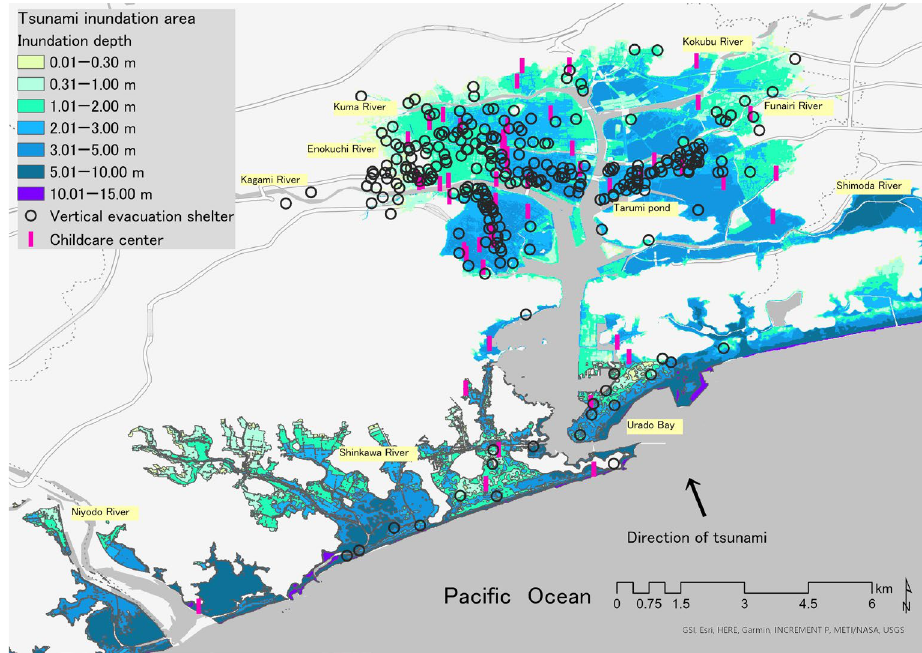
Figure 2. Childcare centers and vertical evacuation shelters in tsunami inundation area of Kochi City. Gray areas represent the sea; white areas represent the land.